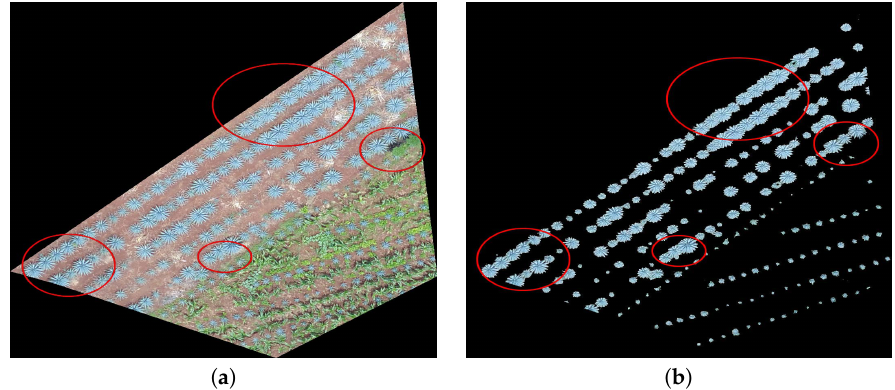
Figure 6. Extraction of the agave layer: the image in ( a ) represents the agave crops without applying the plant extraction methodology in [2]. The image in ( b ) shows the agave detection layer (segmented image) after applying the methodology. Circles in red highlight the overlapping